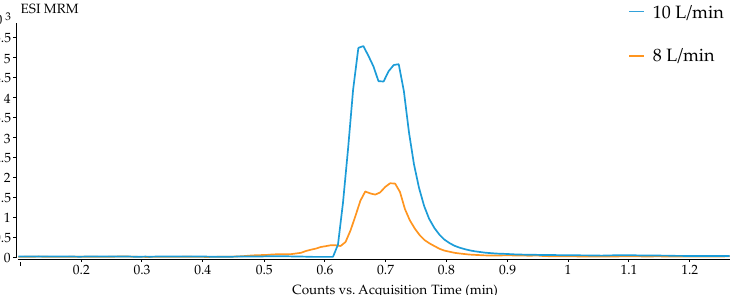
Figure 2. Comparative abundance of lactic acid using a gas and sheath gas flow of 8 L/min (orange) or 10 L/min (blue).